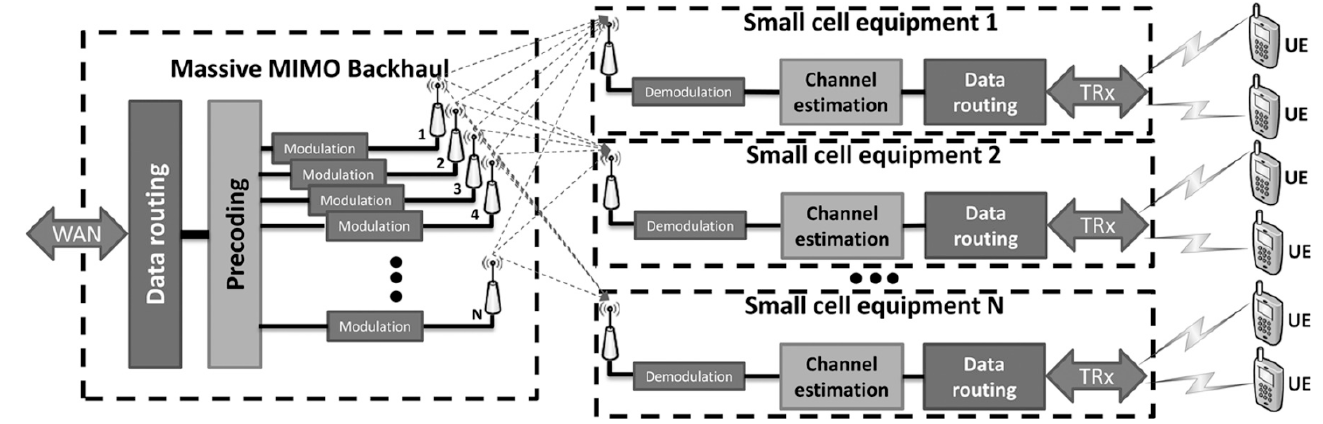
Figure 1. Functional block diagram of massive MIMO system [26].